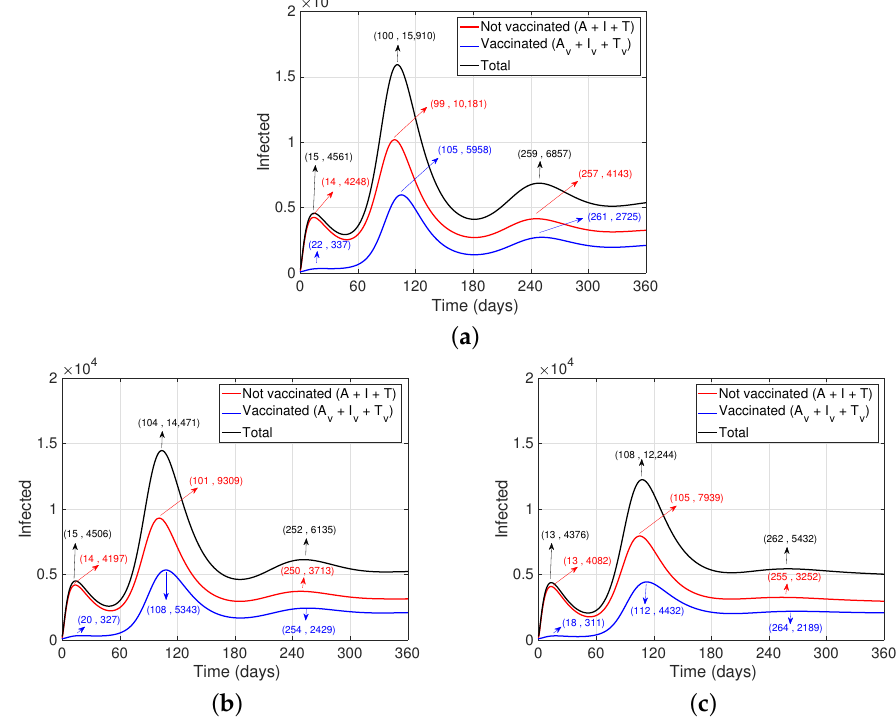
Figure 4. Dynamics of the behavior of the pandemic after varying the perception of risk baseline values. ( a ) Base case. ( b ) Halving of the rate of resistance to change ( Λ 1 ), that is, people are less reluctant to behavioral change. A similar graph is obtained after doubling the speed of people’s reaction to the pandemic ( Λ 2 ). ( c ) Reduction of resistance to change by half and increase in reaction speed by